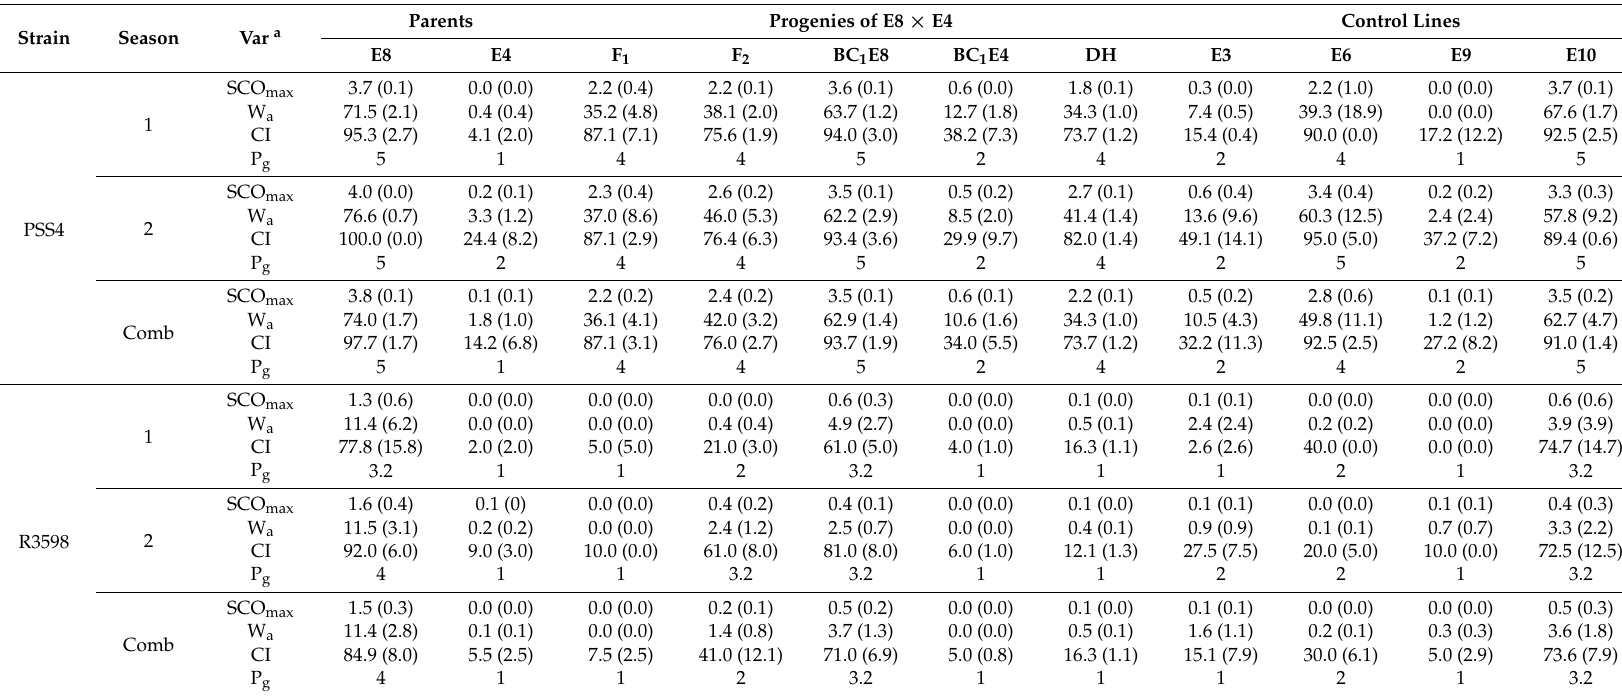
Table 1. Mean and standard deviation (in parenthesis) for parental lines, progenies of the cross EG203 (E4) × MM738 (E8), doubled haploid (DH) and control lines, challenged with PSS4 and R3598 R. pseudosolanacearum